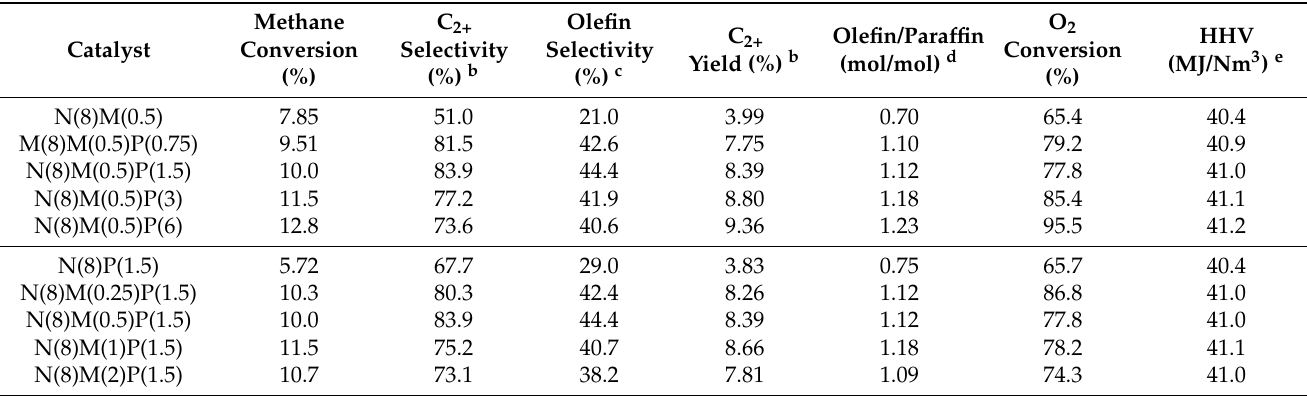
Table 4. OCM results of simulated biogas at 800 ◦ C using catalyst pellet depending on the composition of the inorganic and organic binders a .